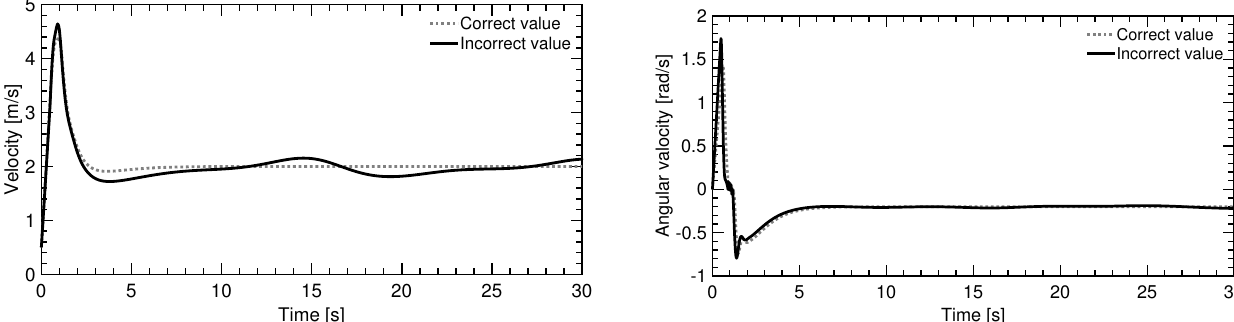
Figure 21. Trajectory following test in case of incorrect knowledge of resistance coefficients: instantaneous forward velocity ( left ) and rotational velocity ( right ).